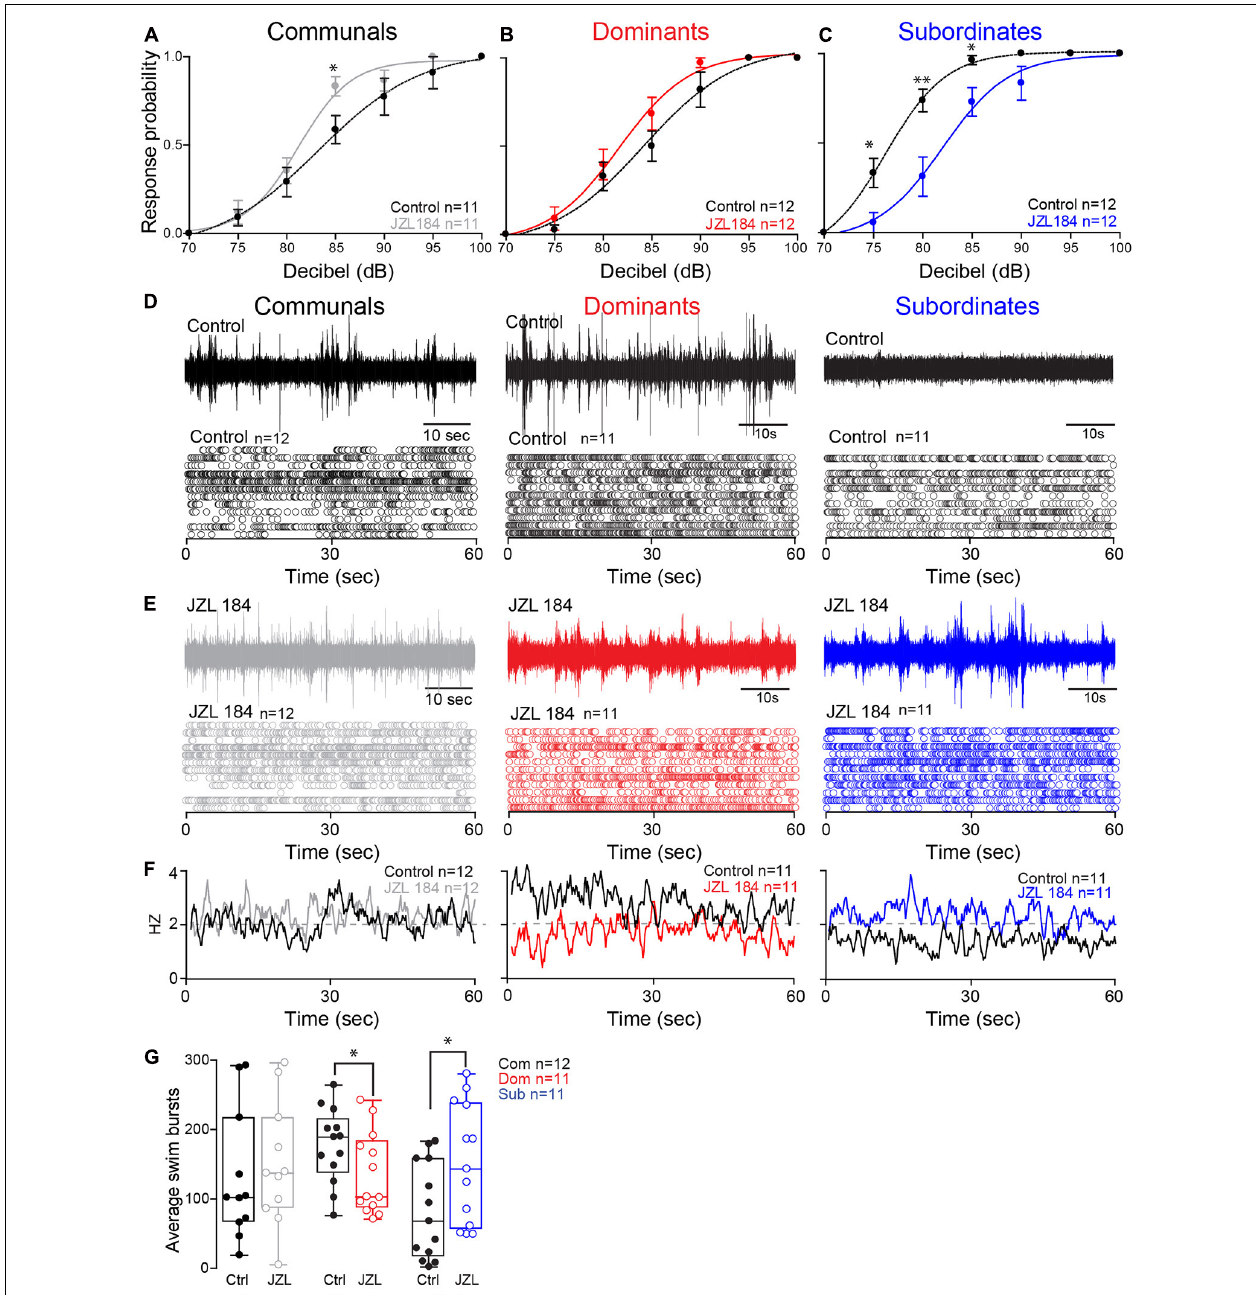
FIGURE 3 | 2-AG modulation of escape and swimming activities is social status-dependent. (A–C) Probability of startle escape response before (control) and after JZL184 injections for communals, dominants and subordinates, respectively. Asterisks ( ∗ p < 0.05, ∗∗ p < 0.005) denote statistical difference between control and experimental condition at the specified dB level. (D) 1 min recoding of far field-potentials of spontaneous swimming activity before (control) and (E) after JZL184 injections for communal, dominants and subordinates, respectively, along with respective raster plots of each condition. (F) Average swimming frequency for all animals tested before and after JZL184 injection. (G) Box and whiskers plots of the average number of swim bursts per 1 min for each social phenotype. Dots represent individual animals. The box extends from the 25th to 75th percentiles, horizontal line is the median, and whiskers represent max/min values.